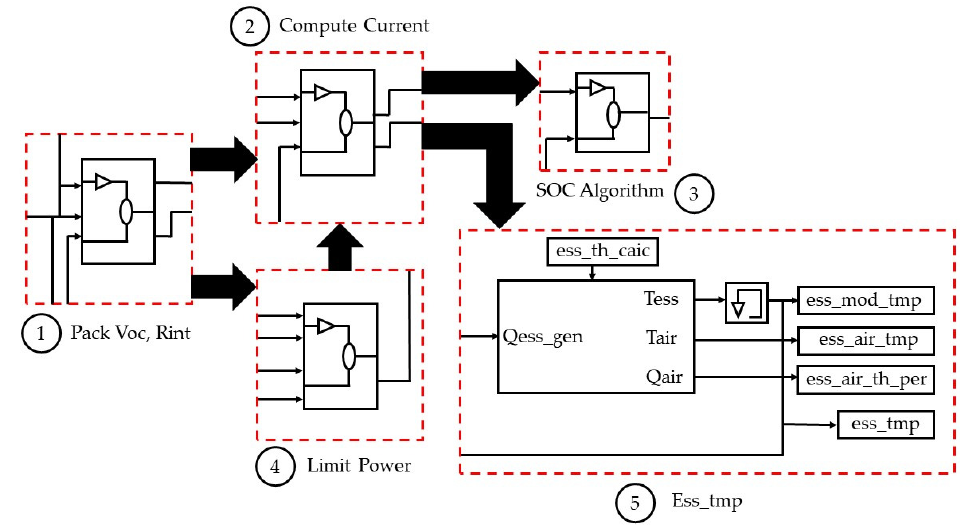
Figure 3. Top-level model diagram of battery module: ( 1 ) pack Voc, Rint, ( 2 ) compute current, ( 3 ) SOC algorithm, ( 4 ) limit power, and ( 5 ) ess_tmp